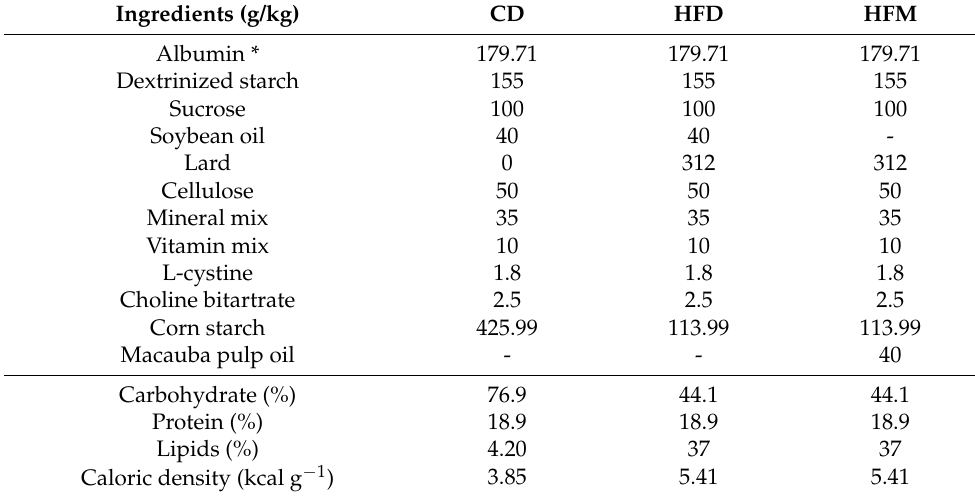
Table 1. Composition of experimental diets (g/kg of